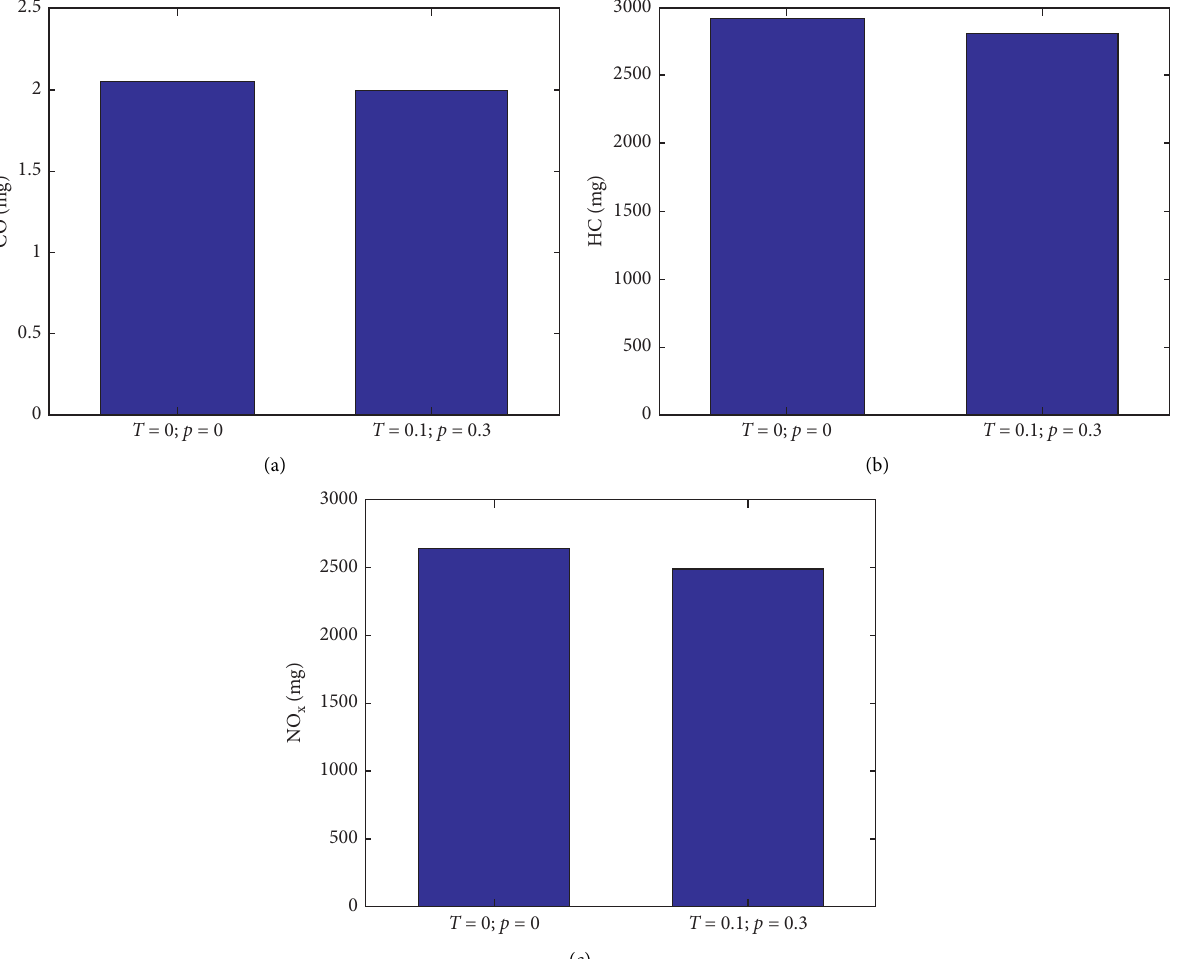
Figure 17: The total CO, HC, and NO x emission of 50 vehicles simulated by simulated by the AFVD model ( T model ( T � 0.1, p � 0 . 3) at time step 1000s: (a) CO, (b) HC, and (c) NO x